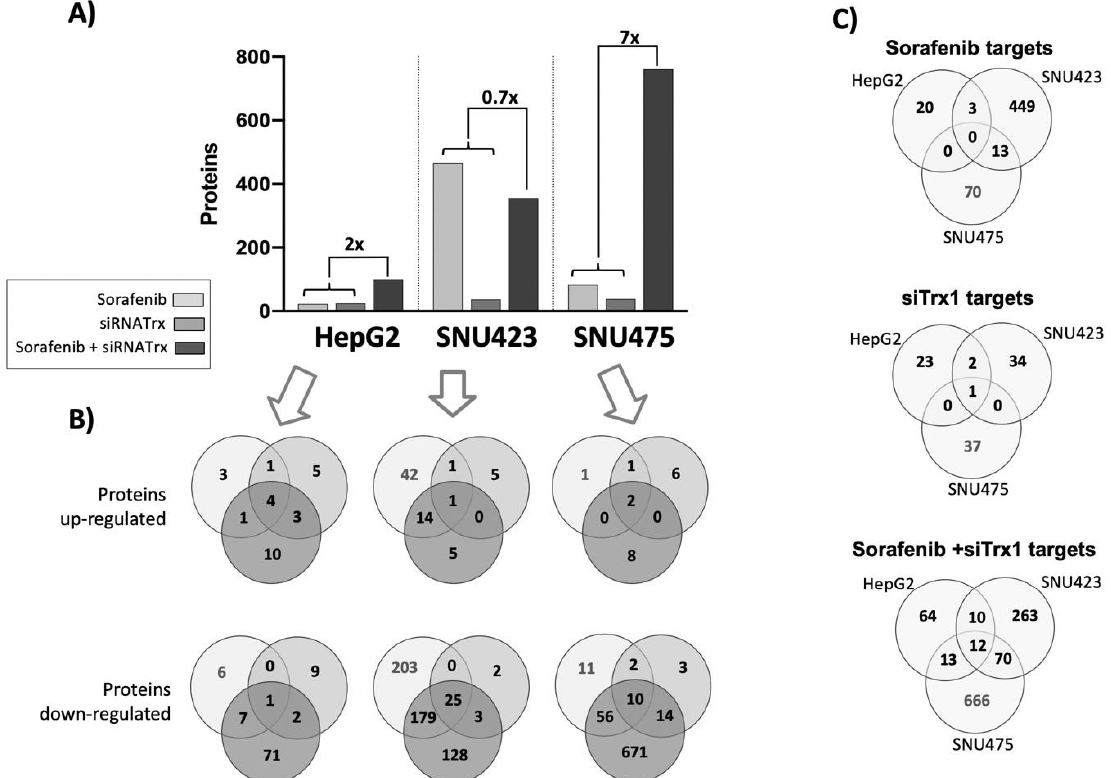
Figure 4. Summary of the quantitative proteomic analysis of HCC cell lines subjected to Sorafenib and / or siRNATrx1 treatments. ( A ) The total number of significantly (adjusted p ≤ 0.05) di ff erent proteins (fold change ≥ 1.5 and ≤ 0.6) quantified upon each treatment relative to their controls; the numbers above the brackets and thin lines are the “synergy factor” reached by siRNATrx1 and Sorafenib calculated by the ratio between the number of proteins a ff ected by the combined treatment and the number of proteins a ff ected by individual Sorafenib and siRNATrx1 treatments. ( B) Venn diagrams of upregulated and downregulated proteins by each treatment, by cell line; the color code indicated in the legend applies to (A) and (B). ( C ) Venn diagrams of proteins a ff ected in each cell line by treatment.